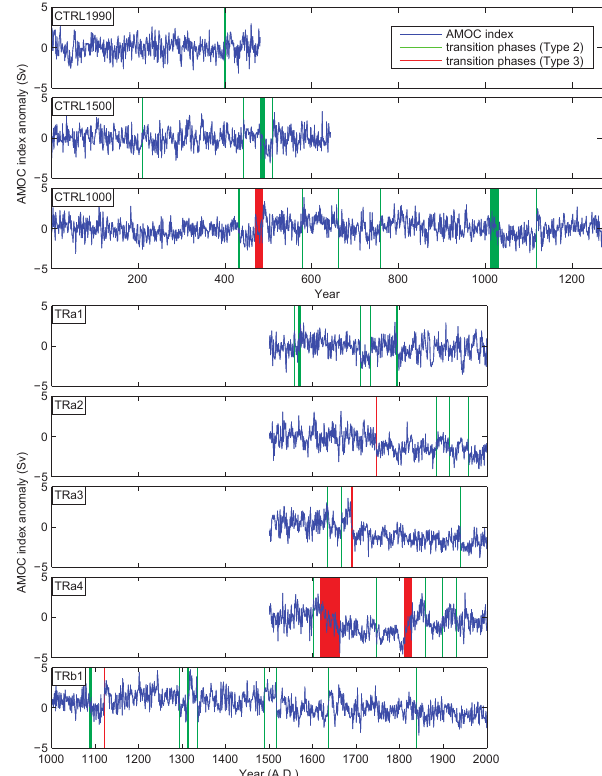
Fig. 5. Annual mean AMOC index anomaly time series and the transition phases identified by the ramp function regression anal- ysis described in the text. The transitions are grouped into Type 2 (green) and Type 3 (red). The two Types are defined according to the characteristics of the AMOC difference pattern (see Fig. 6). The width of the colored bars indicates the duration of the linear transition from stronger to weaker AMOC (and vice